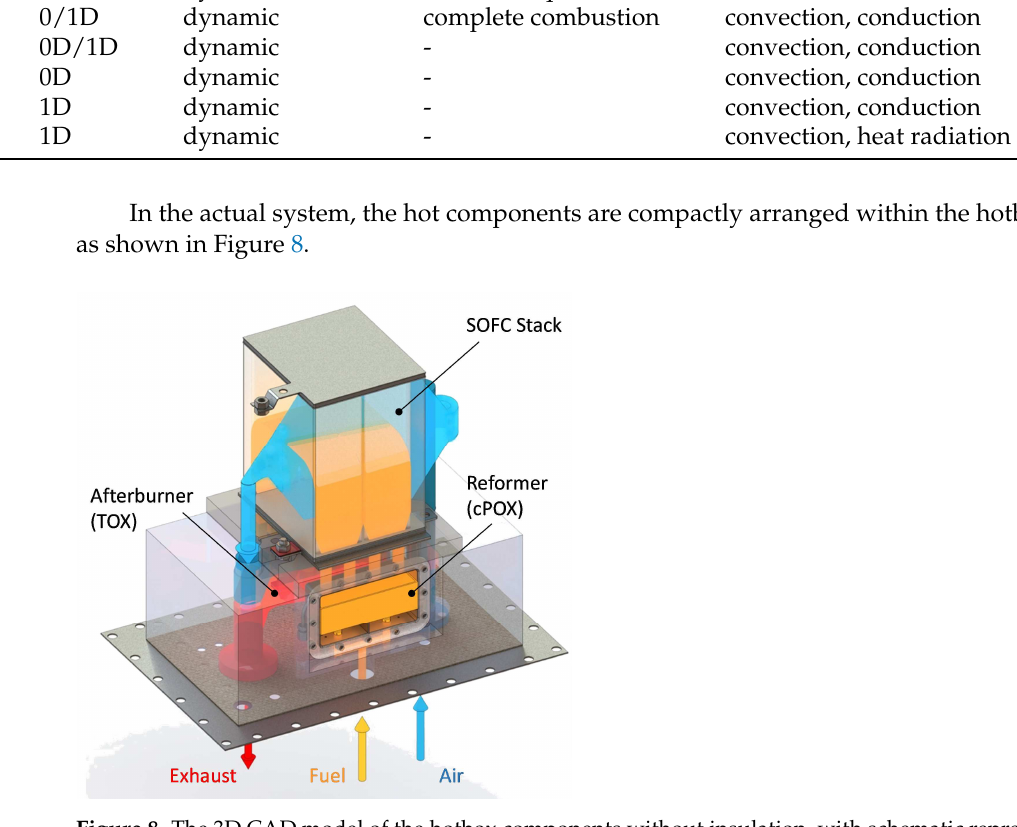
Figure 8. The 3D CAD model of the hotbox components without insulation, with schematic represen- tation of the